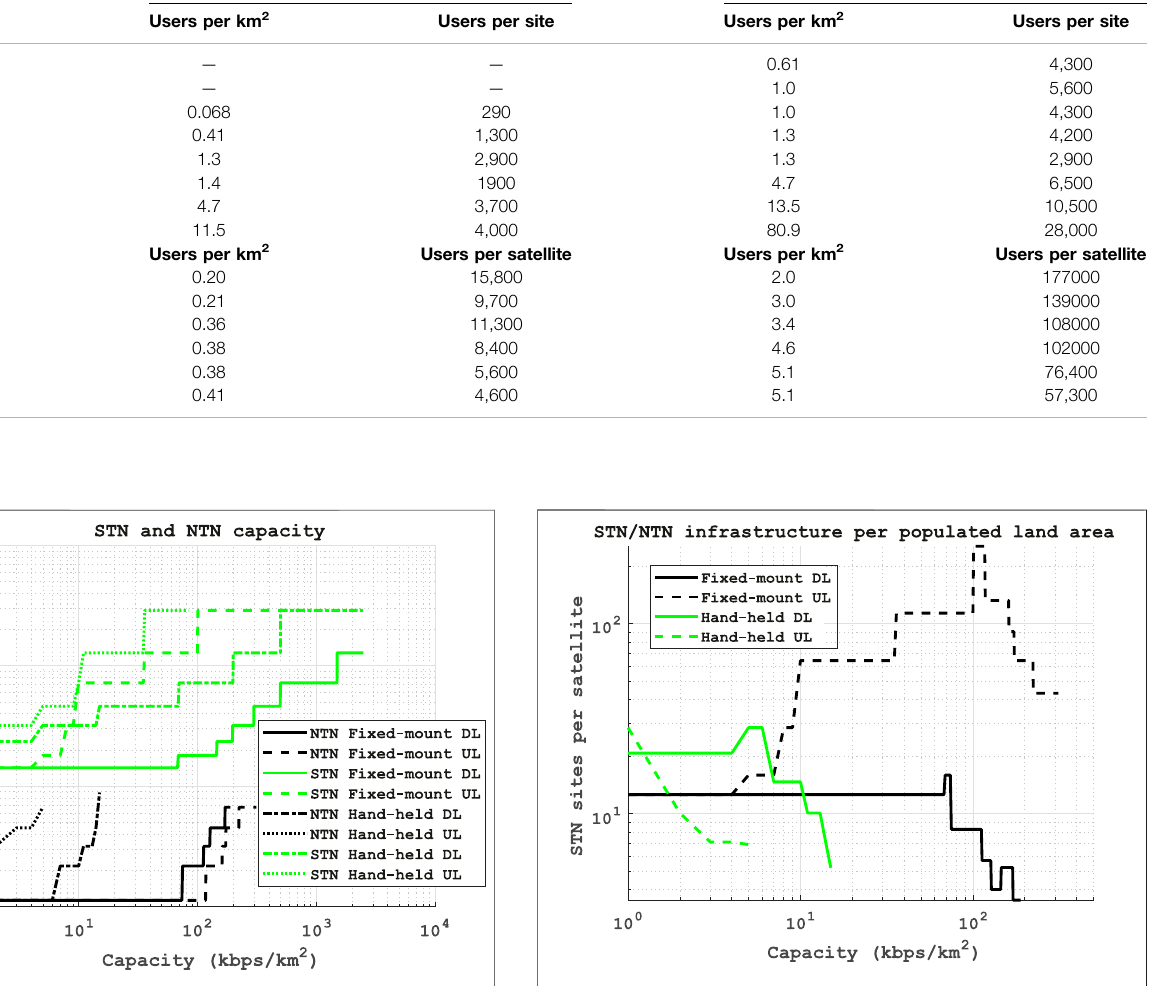
FIGURE10| RatioofSTNsitestoNTNsatellitesperpopulatedlandarea for 95% service coverage, as function of served traf fi c. Note: values only for overlapping capacity